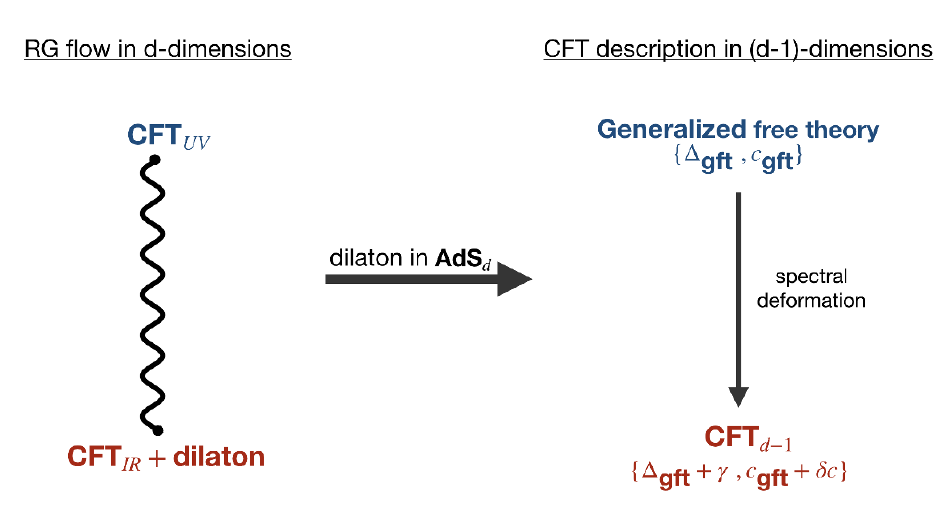
Figure 1 . Every RG (cid:13)ow connecting two conformal (cid:12)xed points CFT UV and CFT IR in d spacetime dimensions can be equivalently described as a CFT in ( d (cid:0) 1) spacetime dimensions for d (cid:21) 3. The CFT d (cid:0) 1 is obtained by deforming operator dimensions and OPE coe(cid:14)cients of a ( d (cid:0) 1) dimensional generalized free